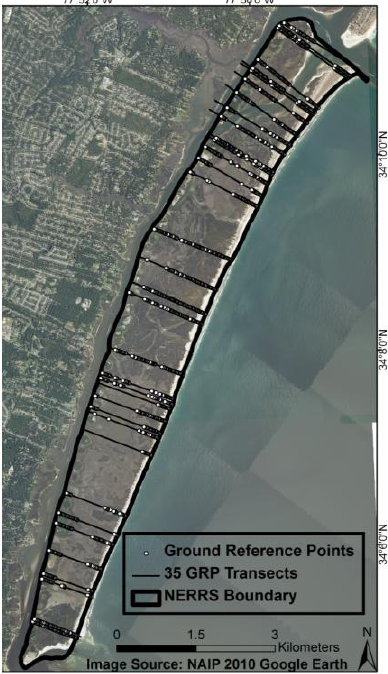
Figure 3. Masonboro National Estuarine Research Reserve System study area with ground reference points along 35 randomly selected transects spaced 50 m apart.